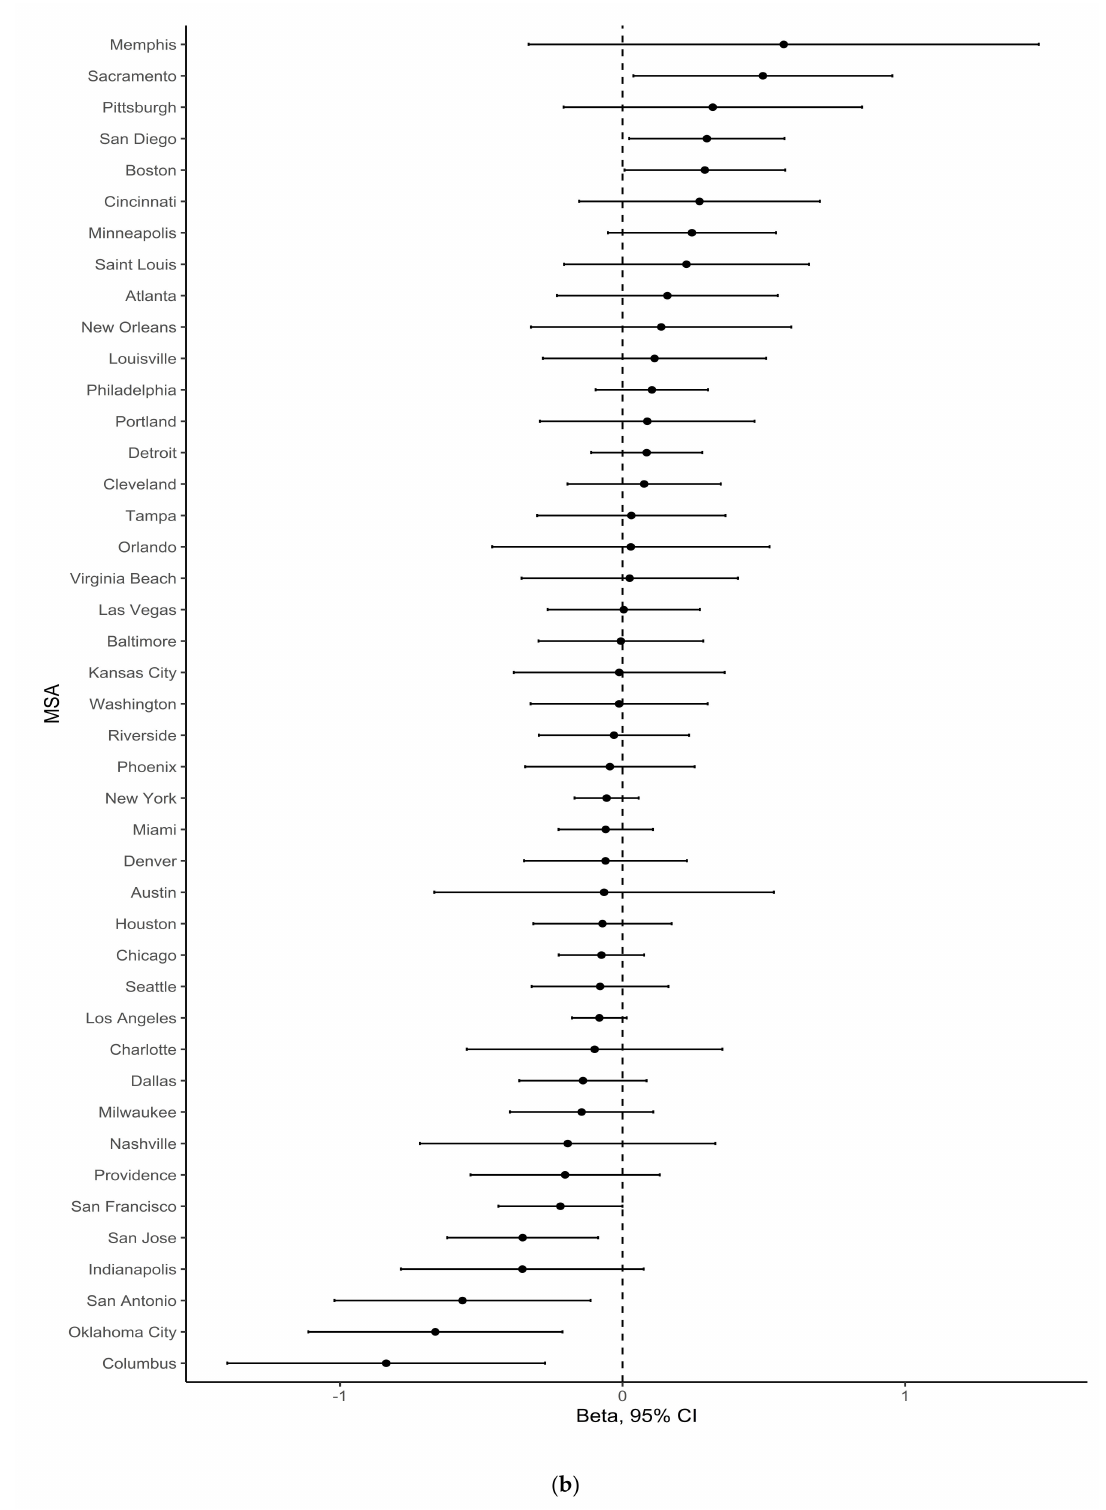
Figure 5. MSA-specific estimates of association between percentage greenspace and changes in percentage of the civilian population ages 16 and over working professional jobs, for the periods ( a ) 1990–2000 or ( b ) 2000–2010. Estimates for the 1990–2000 period represent comparisons of census tracts with percentage greenspace > 75th percentile vs. ≤ 50th percentile for their MSA. Estimates for the 2000–2010 period represent comparisons of census tracts with percentage greenspace > 75th percentile vs. ≤ 75th percentile for their